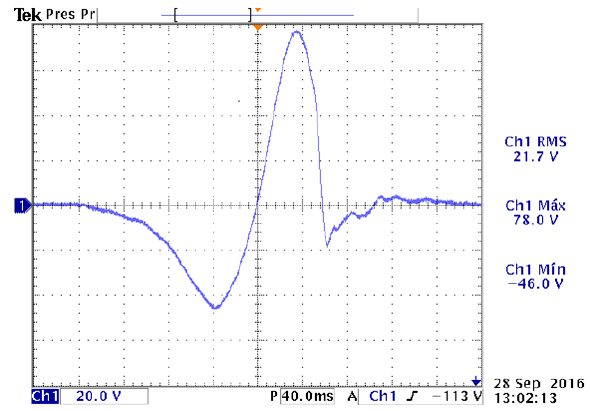
Figure 8. Experimental pulse voltage of the harvesting. Device/generator at no-load condition.